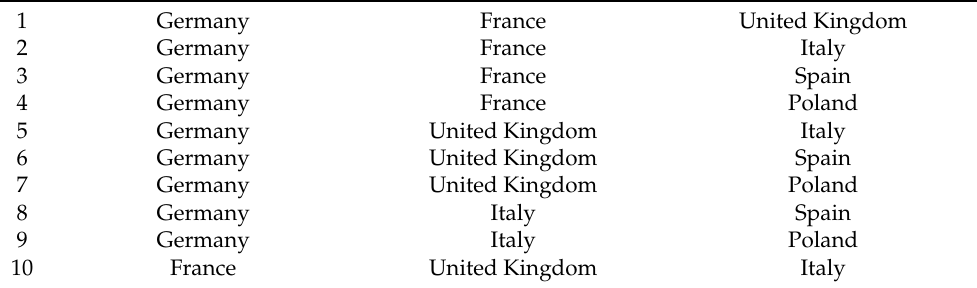
Table A5. Coalitions which reach the population quota but cannot reject a decision in the 28-member